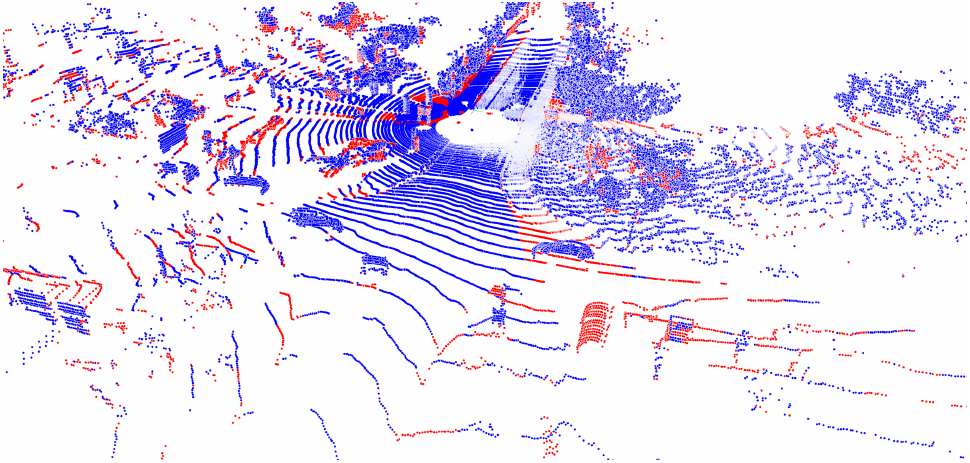
Figure 7. Map for disagreeing points. Agreement is visualized in blue and disagreement in